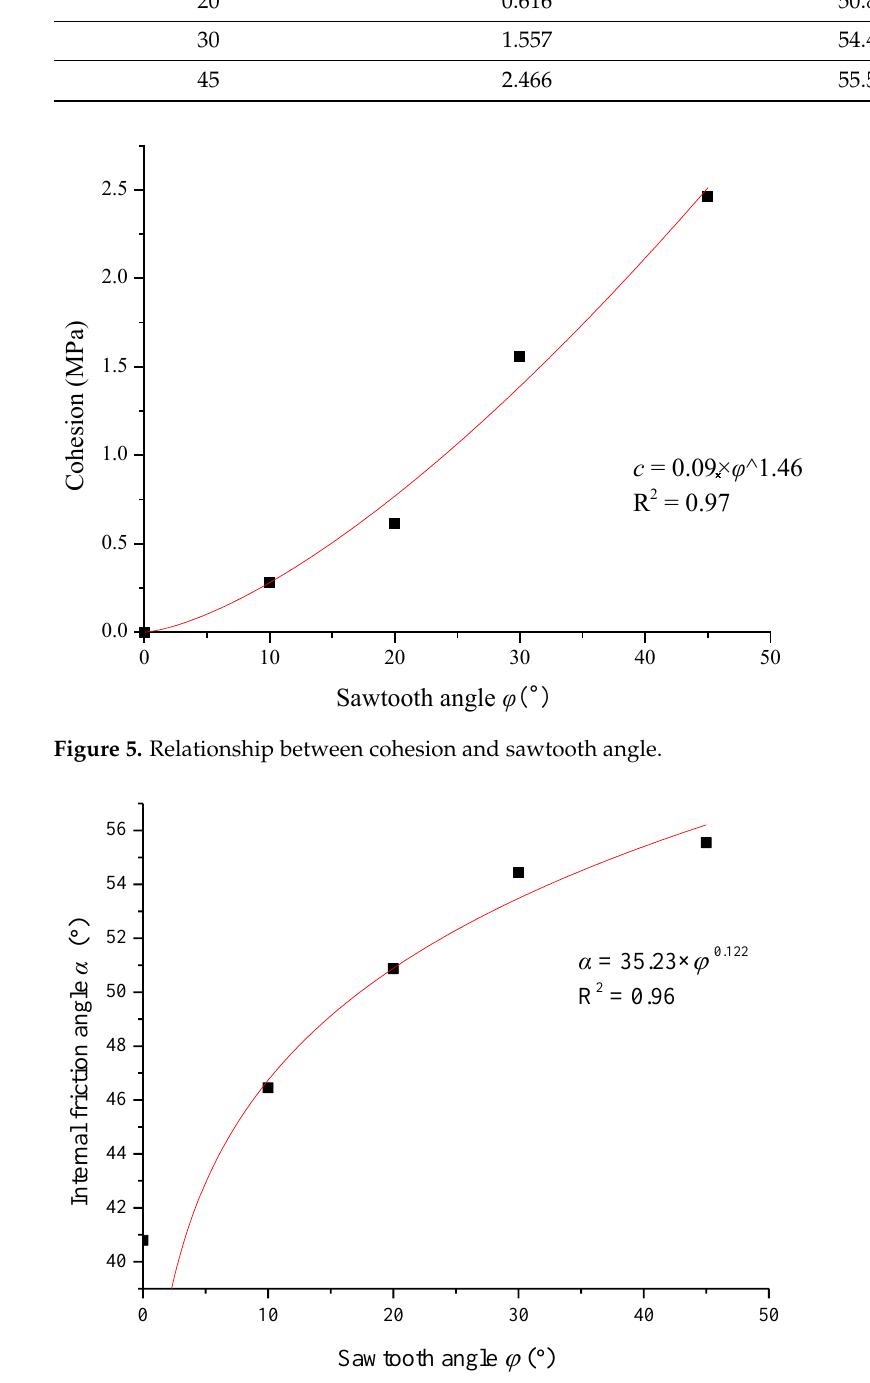
Figure 6. Relationship between internal friction angle and sawtooth